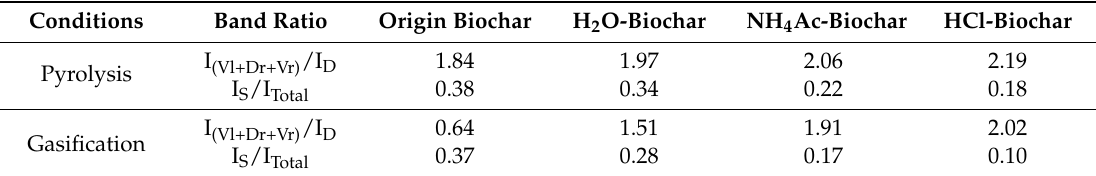
Table 2. Ratios of band peak areas in pyrolysis and steam gasification biochar from Chemical fractionation analysis